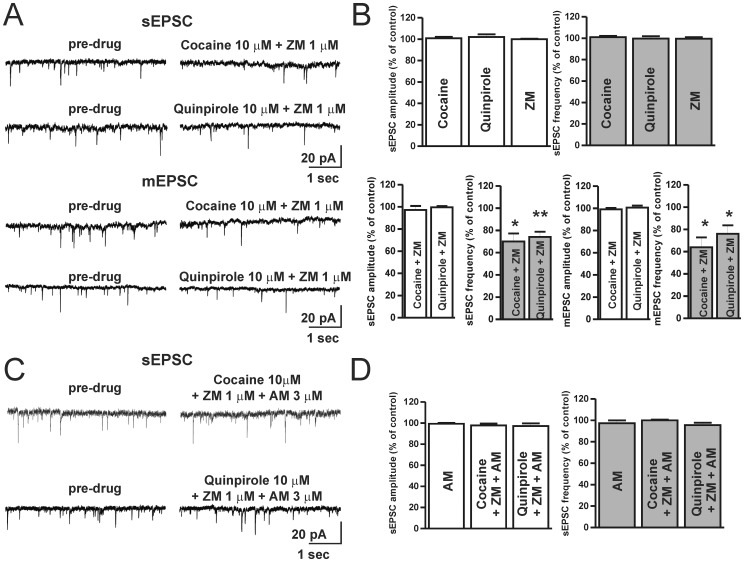
The co-application of cocaine or quinpirole together with A2A-R antagonist similarly reduce spontaneous EPSC by a CB1 receptor-dependent action.(A) Representative traces of sEPSCs and mEPSCs recorded in control conditions (pre-drug) and in the presence of 10 µM cocaine plus 1 µM ZM or 10 µM quinpirole plus 1 µM ZM. (B) Histogram of averaged amplitude and frequency of sEPSCs in the presence of cocaine, quinpirole and ZM applied in isolation (top). Averaged amplitude and frequency of sEPSCs and mEPSCs measured in the presence of cocaine or quinpirole co-applied with ZM (bottom), (sEPSC frequency: cocaine plus ZM, vs pre-drug, t(5) = 3.7, P<0.05; cocaine plus quinpirole, vs pre-drug, t(7) = 4.6, P<0.01. mEPSC frequency: cocaine plus ZM, vs pre-drug, t(4) = 3.2, P<0.05; cocaine plus quinpirole, vs pre-drug, t(4) = 2.9, P<0.01). (C) Traces of sEPSCc in control conditions (pre-drug) and after the co-application of cocaine or quinpirole plus ZM and the CB1-R antagonist AM251. (D) Averaged sEPSC amplitude and frequency in the presence of AM251, cocaine plus ZM plus AM or quinpirole plus ZM plus AM. *P<0.05; **P<0.01.